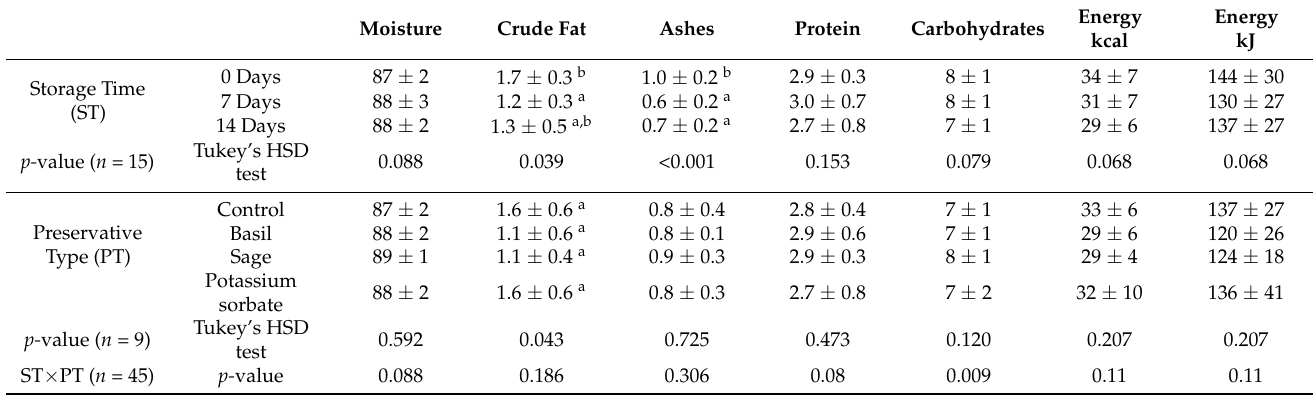
Table 3. Nutritional composition of the yogurts with the different extracts and preservatives (g/100 g fw). Moisture Crude Fat Ashes Protein Carbohydrates